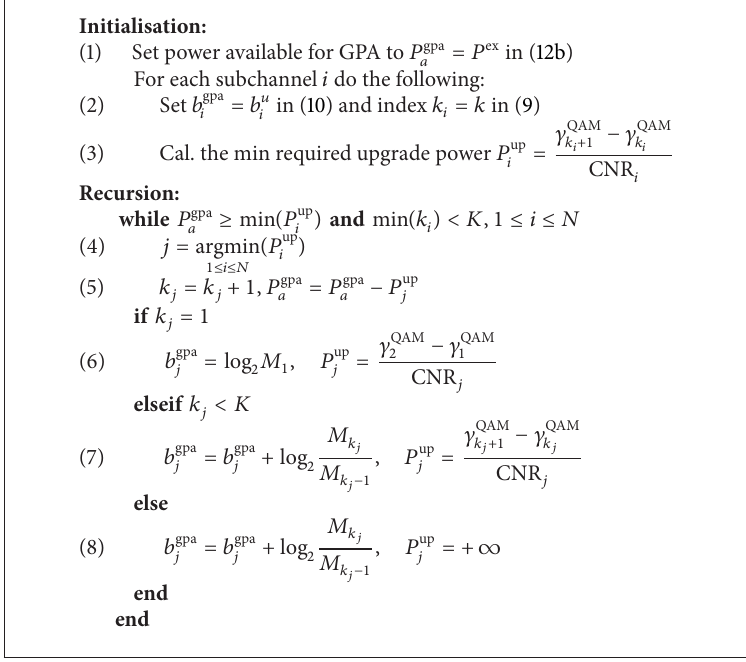
Algorithm 1: Full GPA algorithm applied to the initialisation step of the UPA